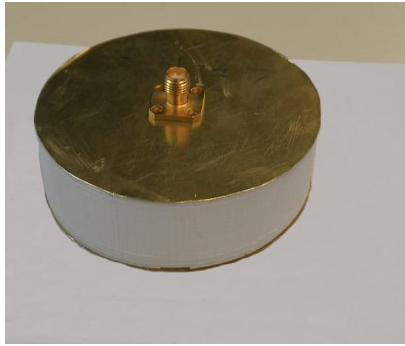
Figure 14. Final assembled prototype of the realized 3D chipless tag.